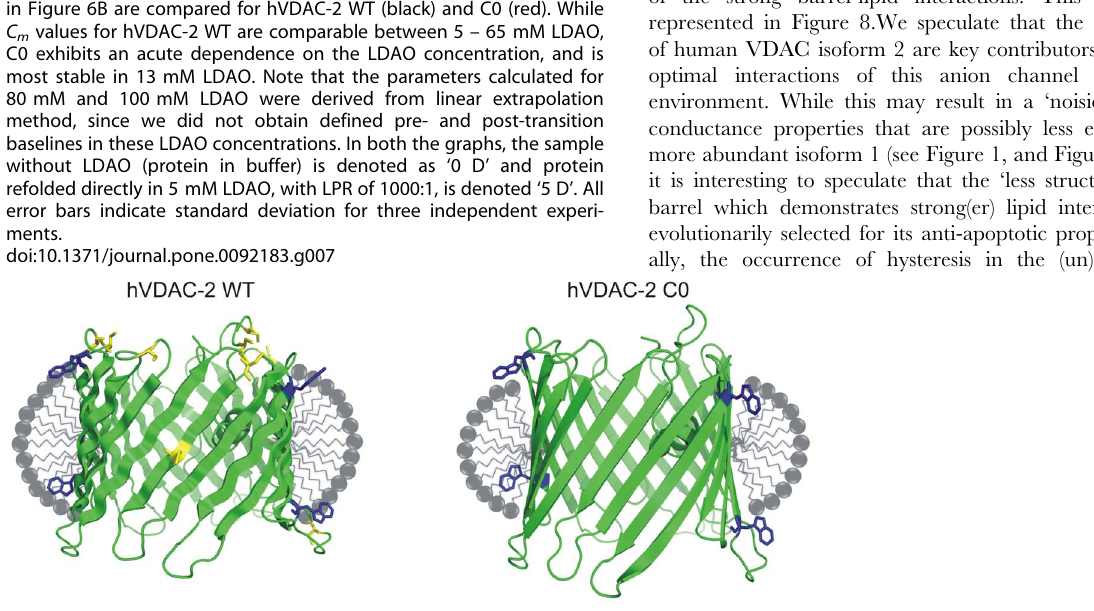
Figure 8. Schematic illustration of the relationship between hVDAC-2 stability and cysteine residues. The nine cysteine residues in hVDAC-2 WT stabilize the refolded barrel by strong protein-LDAO interactions. On the contrary, C0 shows poorer interaction efficiency with the surrounding LDAO milieu. Previous studies have indicated that the WT barrel shows less thermal stability compared to the Cys-less protein [24]. This indicates that hVDAC-2 WT possibly possesses weaker or fewer interstrand interactions and forms a ‘less structured’ barrel. On the other hand, the existence of strong intra-protein interactions in hVDAC-2 C0, evident from its greater thermal stability [24], contradicts the observed destabilization of this construct under equilibrium chemical unfolding. We speculate that native hVDAC-2 compensates for the poorer intra-protein interactions by the formation of strong association with its lipid or detergent environment, illustrated here as additional detergent molecules in the micelle (detergent molecules are shown in grey). The well-structured barrel in C0 retains fewer stabilizing points of association with LDAO, resulting in compromised barrel-LDAO interactions, which in turn leads to the observed destabilization of C0. The tryptophan and cysteine residues have been shown in blue and yellow,